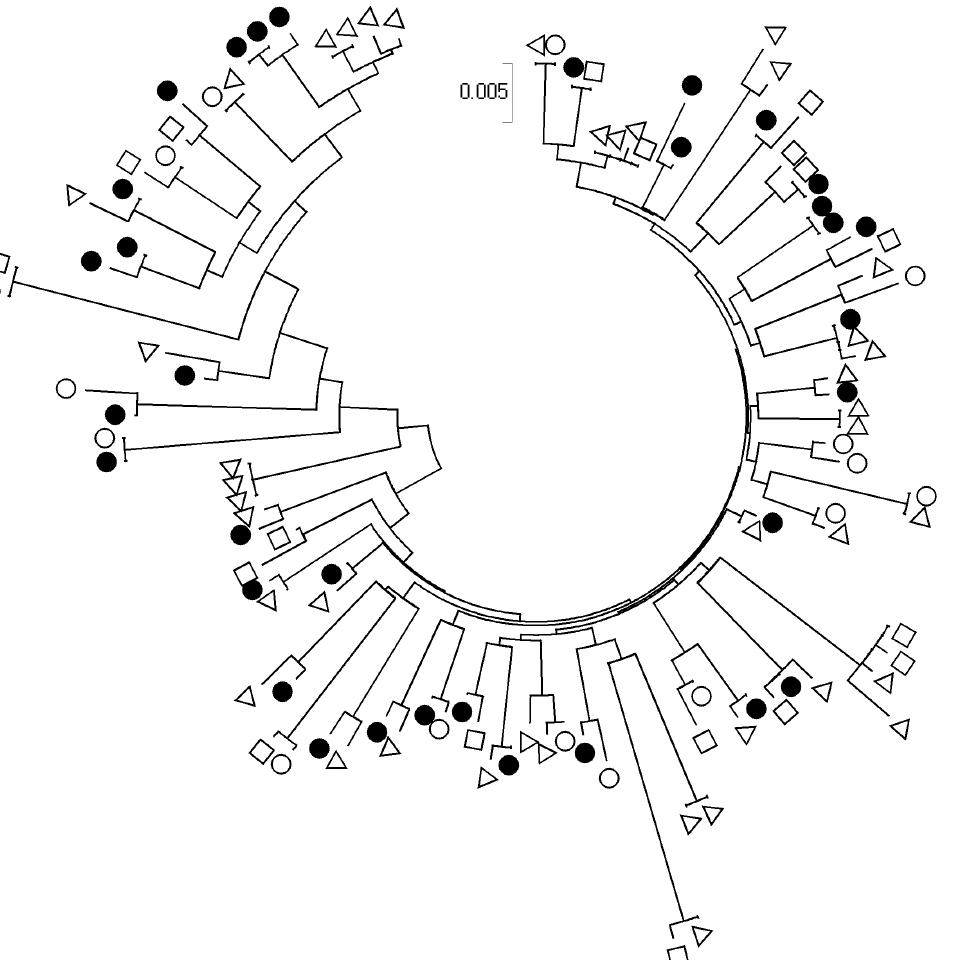
Fig 3. Evolutionary relationships of the 108 HIV-1 reverse transcriptase sequences involved into chained transmissions. Viruses isolated in patients infected for less than 6 months (VEP) ( Δ ), patients chronically-infected with CD4 + T-cell count > 500/mm 3 (EP) (o) or (cid:1) 500/mm 3 ( ● ). Subjects with unknown duration of infection ( □ ) are